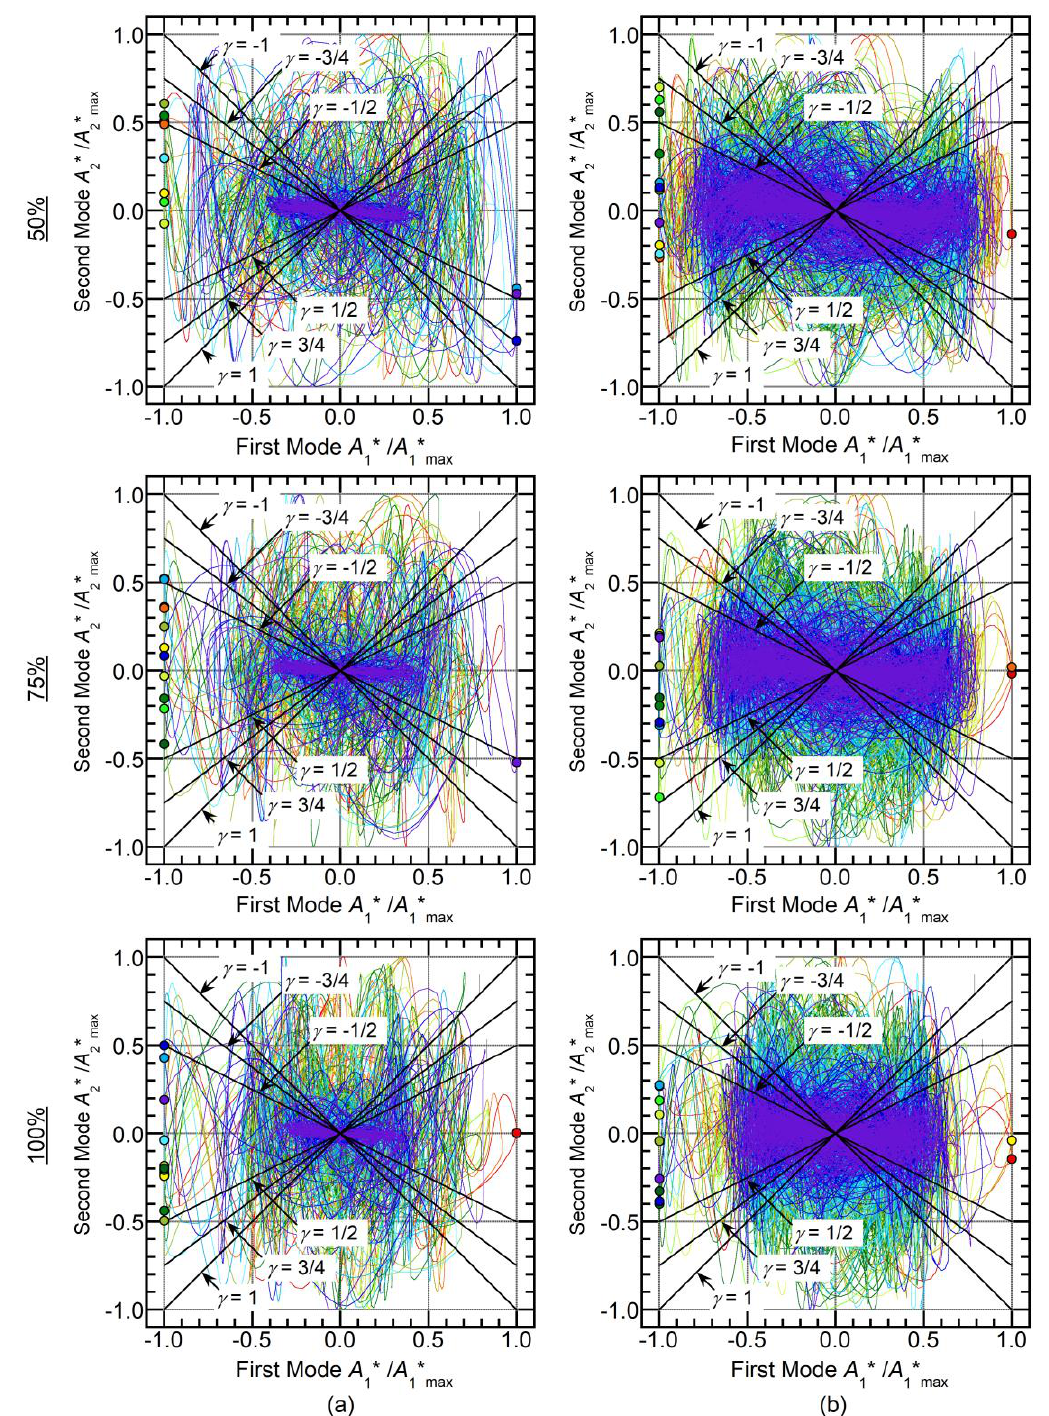
Figure 14. Orbit of normalized equivalent acceleration (Model-14): ( a ) Art-S series and ( b ) Art-L series.